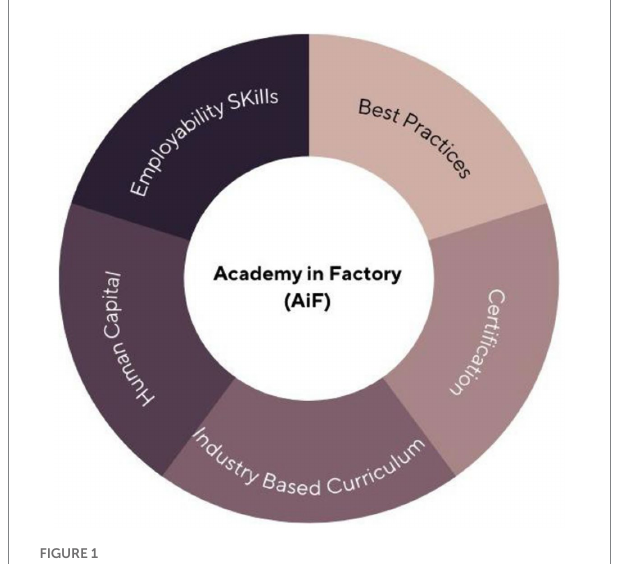
FIGURE 1 Framework for Malaysian